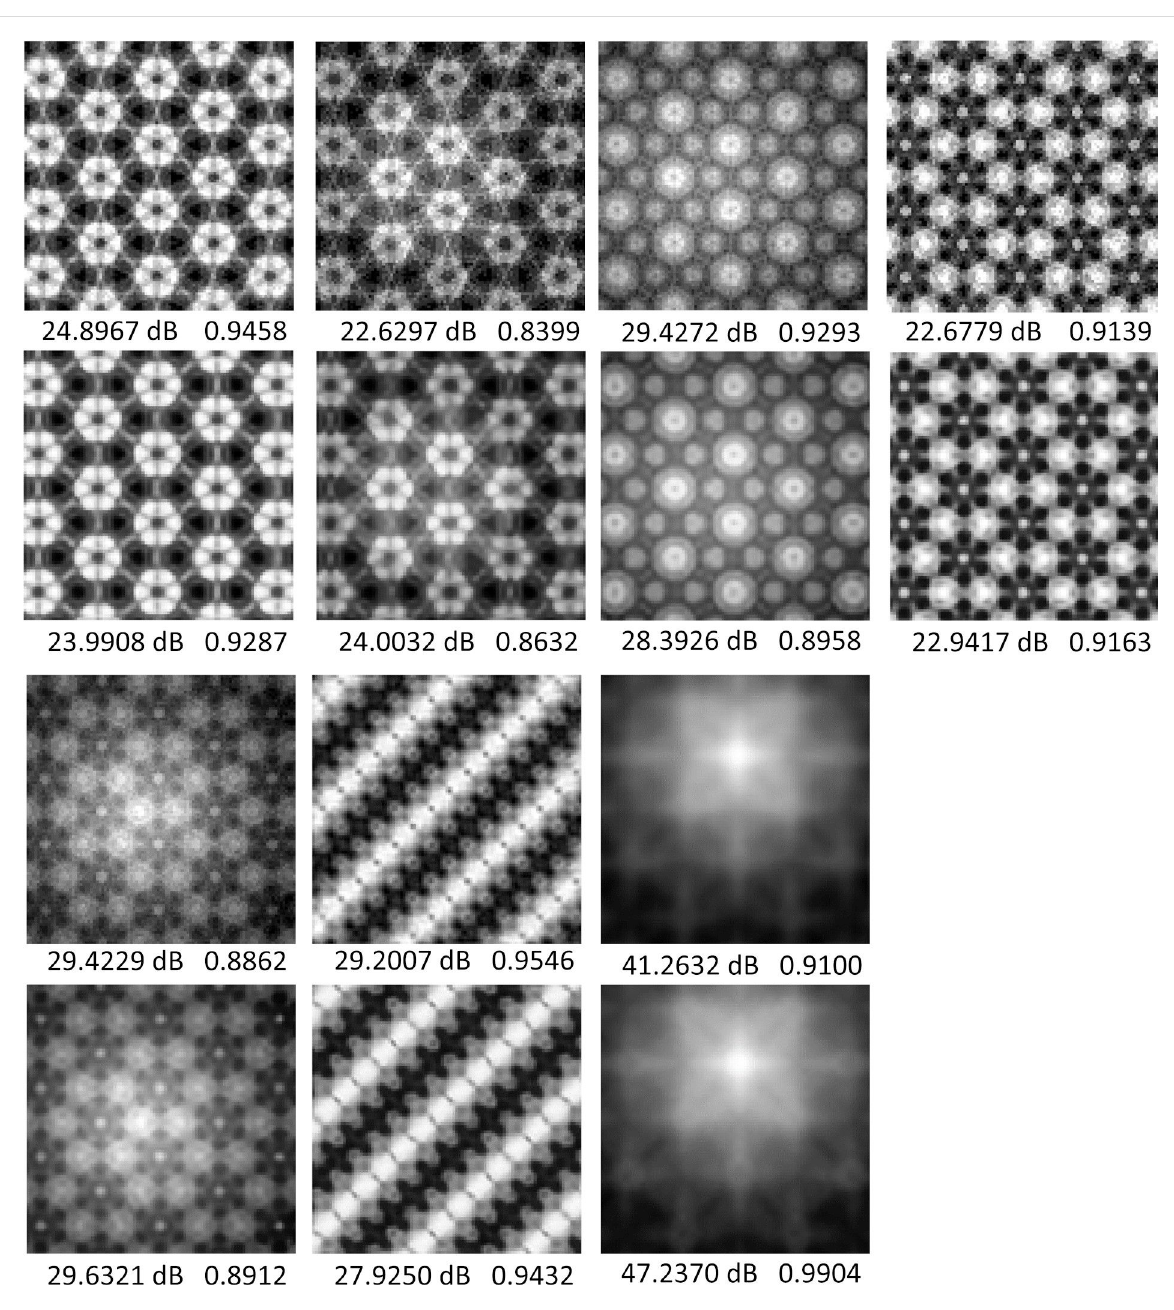
Figure 8: Reconstructed results of the other seven images. The upper image of each group shows the result of the BCS reconstruction with an under- sampling rate of 0.5, and the lower image represents the SRCNN reconstruction with a scale factor of 2×. PSNR and SSIM are indicated below each